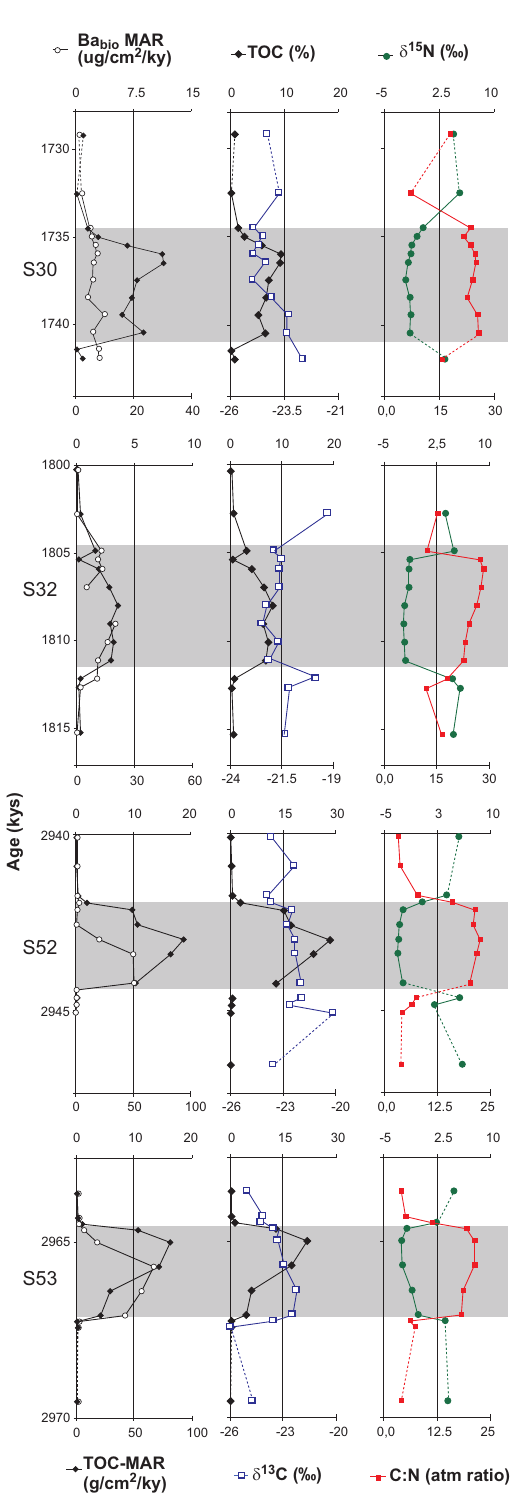
Fig. 6. Geochemical signal and TOC and Ba bio Mass Accumulation Rates, C:N, and C-N isotopic composition for representative Lower Pleistocene from Site 967 and Pliocene sapropels from Site 964. Note different scales for TOC and Ba-MAR’s. Shaded areas correspond to sapropel layers.